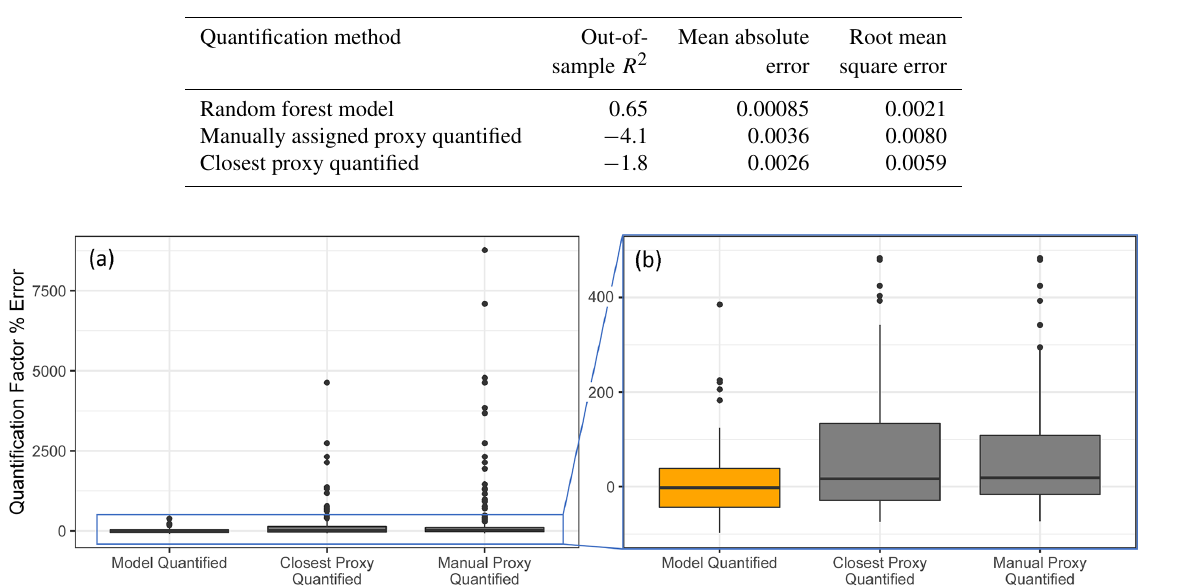
Figure 7. Quantification performance comparison between the random forest model (orange) and two previously utilized quantification methods, specifically the closest proxy quantification and manually assigned proxy quantification. The midline of the boxes indicates the sample median, while the top and bottom indicate the 25th and 75th percentiles. Linear whiskers extend to the least extreme values within 1.5 × of the inner quartile range of the sample. Disconnected dots indicate the sample outliers that fall beyond the whisker